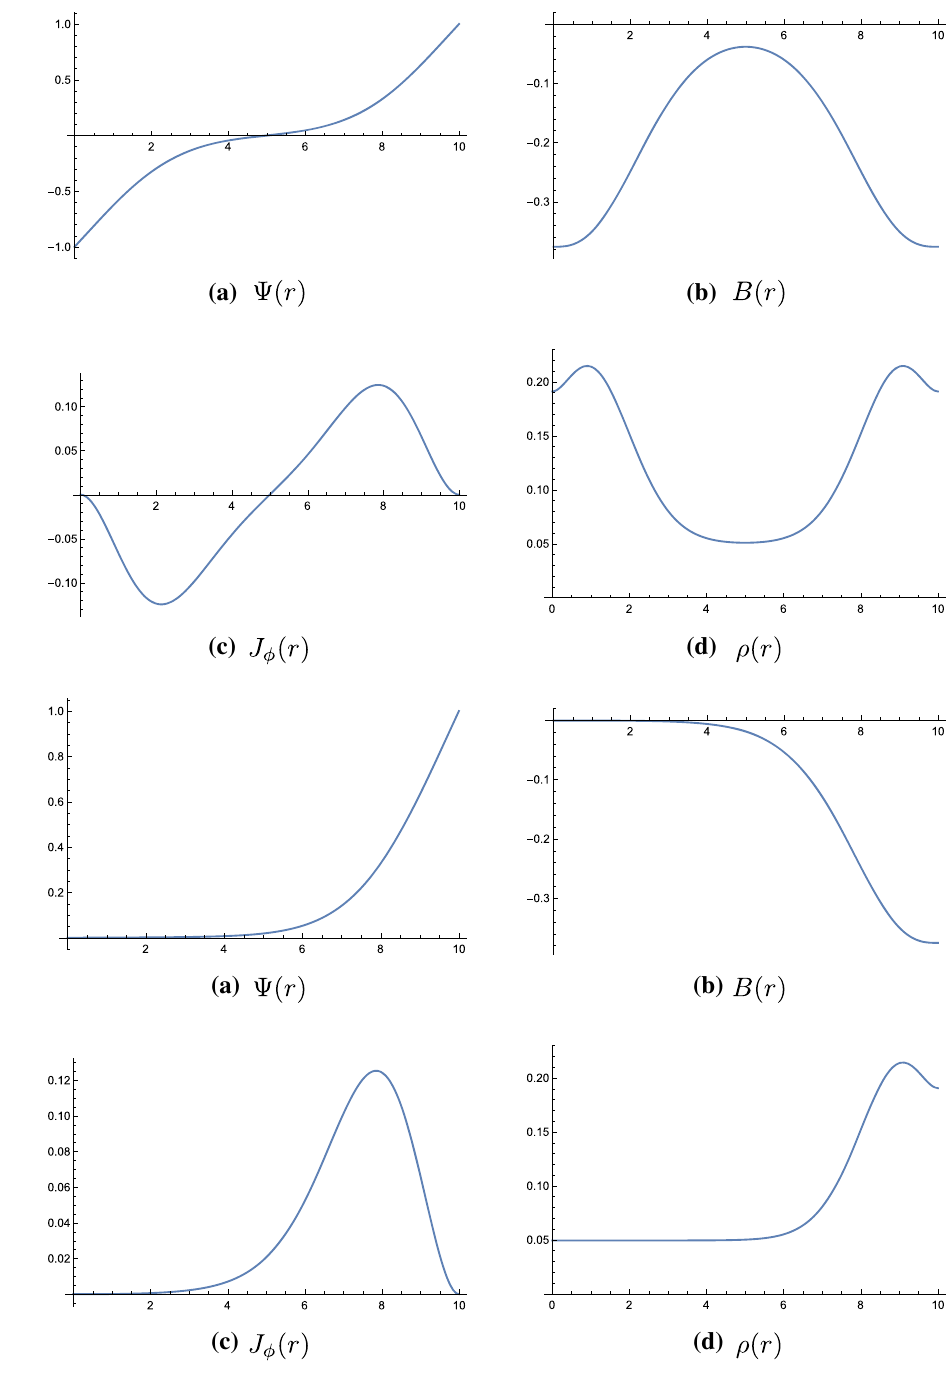
Fig. 12 Profiles for the gauged baryon solution n = 0 with anti-periodic boundaries for (cid:16) .